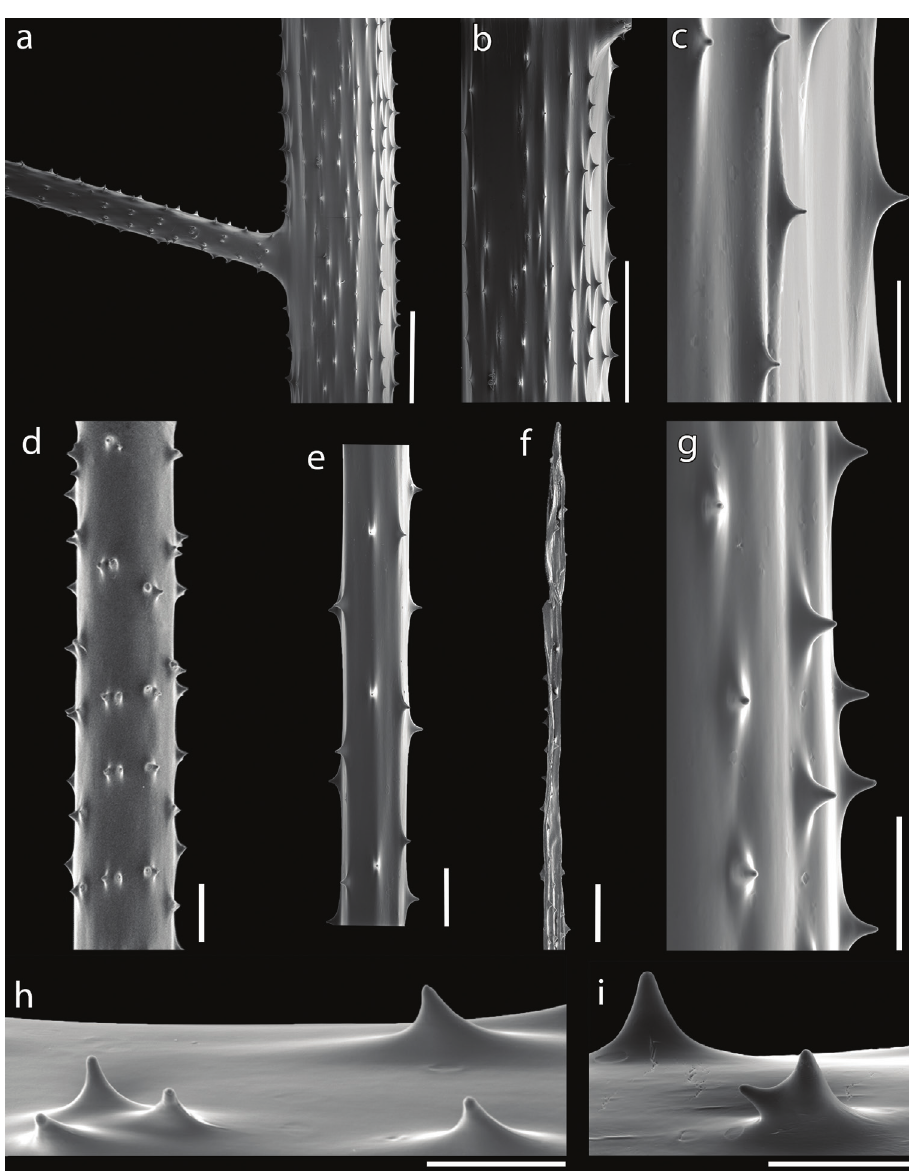
Figure 4. Scanning Electron Microscope of the spines of Bathypathes thermophila sp. nov., MNHN- IK-2016-45 ( a–f, h ), MUZAC-6665 ( g, i ) a stem and pinnule form the middle portion of the corallum b stem from the upper part of the corallum with c detail of the spines. Pinnule from the middle portion of the corallum with details of d proximal portion e distal portion, and f terminal portion g polypar spines on pinnule h row with three polypar spines on a distal pinnule i bifurcated polypar spine on pinnule. The right side of vertical skeletal elements and the upper side of horizontal ones is the polypar side. Scale bars: 500 μm ( a, b ); 100 μm ( c–g ); 50 μm ( h, i